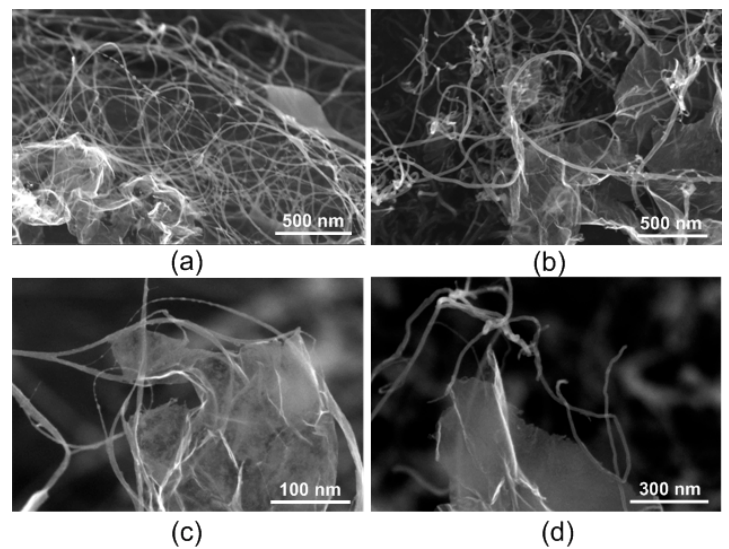
Figure 6. SEM images with different magnification of hybrid structures ( a , c ) SWCNT/rGO and ( b , d ) MWCNT/rGO after laser irradiation.